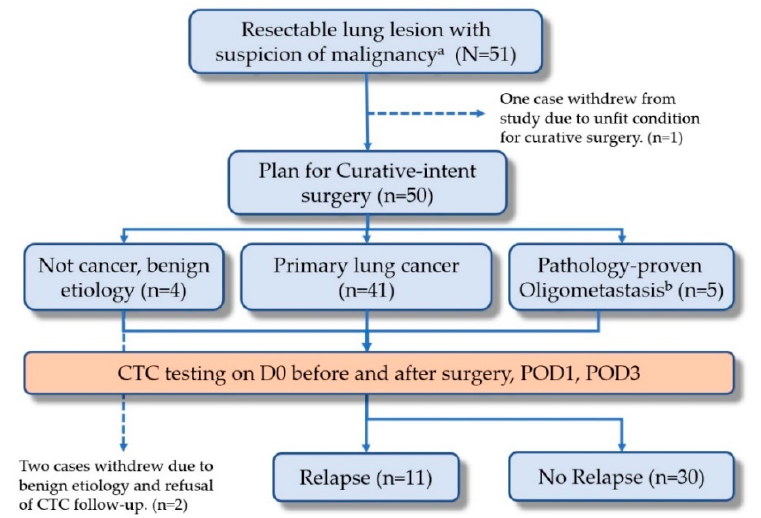
Figure 1. The study flow of the prospective design. (CTC, circulating tumor cell; POD1, postoperative day 1; POD3, postoperative day 3). Table 1. Basic characteristics of enrolled patients. ECOG, Eastern Cooperative Oncology Group; CEA, Carcinoembryonic antigen; SCC. squamous cell carcinoma; CTC: Circulating tumor cells.